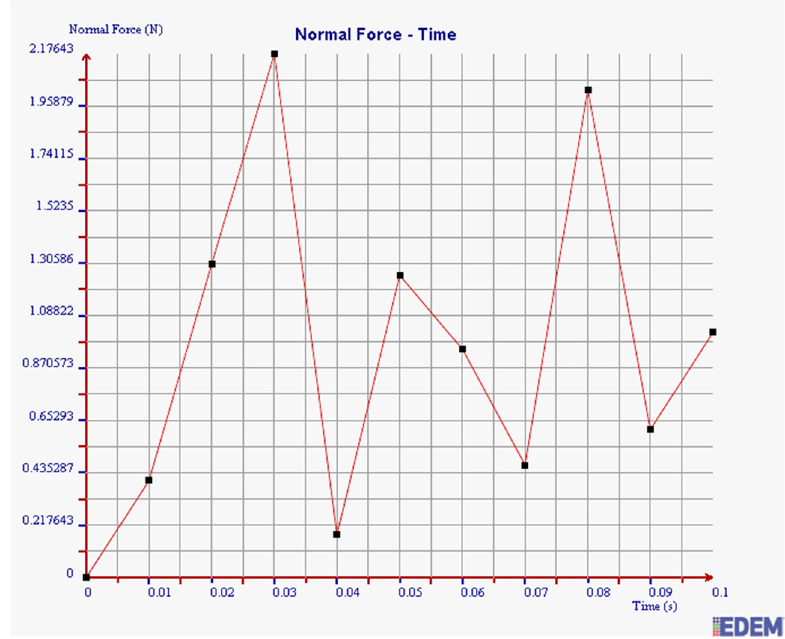
Figure. 15 Normal force of 3 mm steel balls. Figure 15. Normal force of 3 mm steel balls.